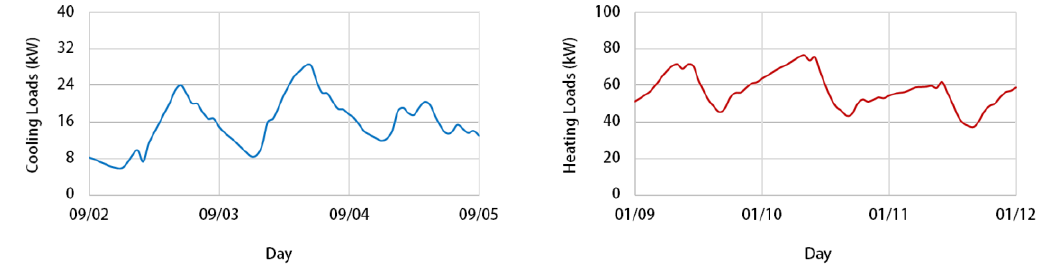
Figure 12. Daily cooling / heating loads of the apartment building.